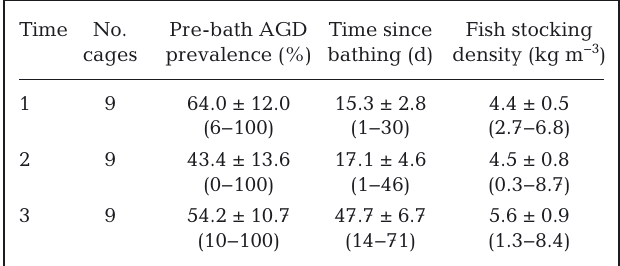
Table 1. Summary statistics of amoebic gill disease (AGD)- related variables across study cages at each time. Values pre- sented are means ± SE (with ranges in